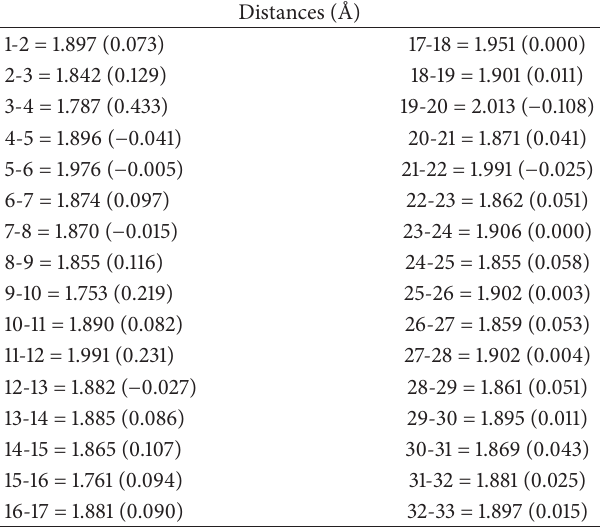
Table 1: Some relevant interatomic distances and their variations (in parentheses) for the GaN/Al numbers identifying the distances refer to Figure